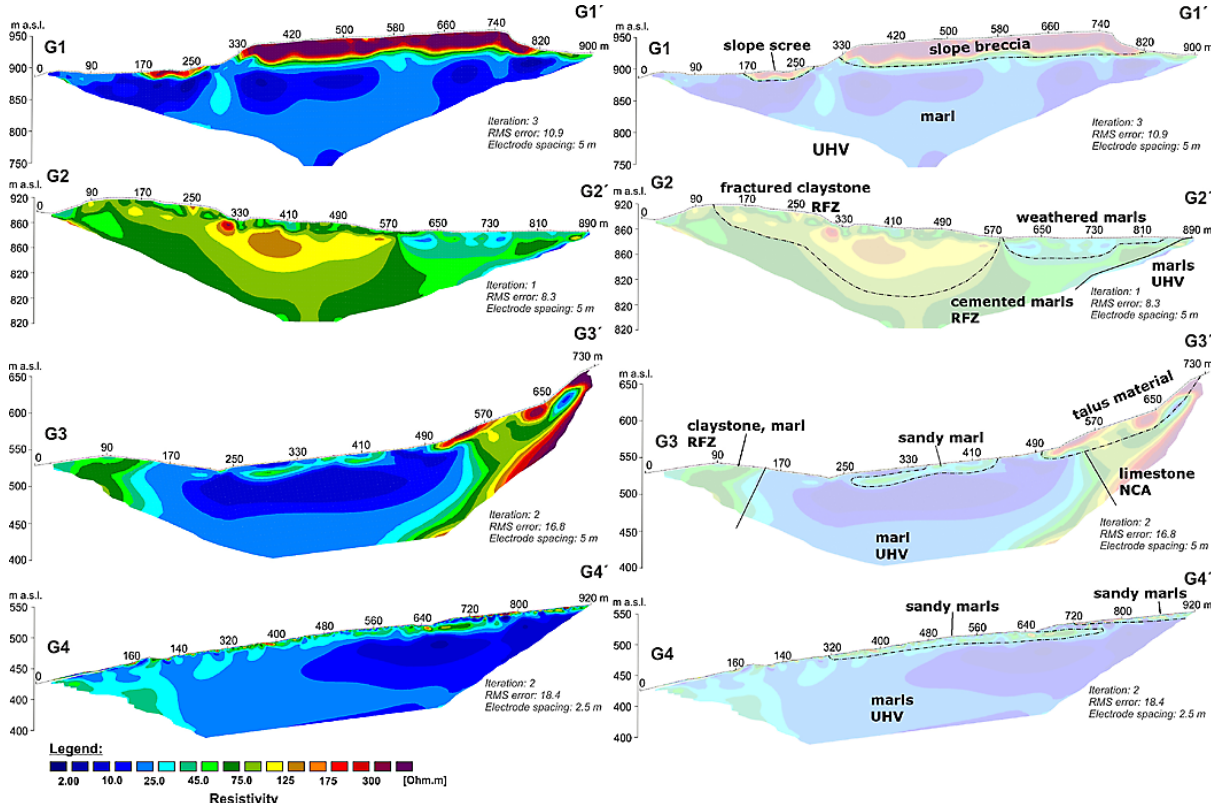
Fig. 10. Inversion results of geoelectrical multi-electrode profiles (left), results with low colour contrast including geological information (right); for location see Fig. 9 (red lines, profiles